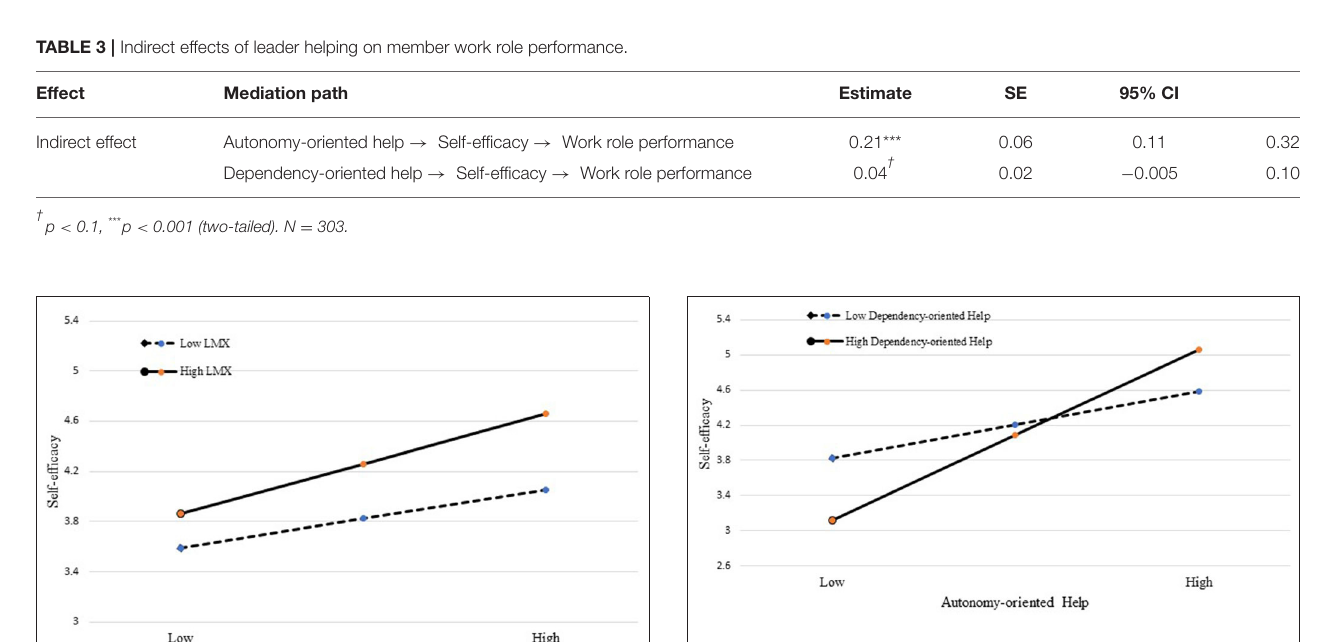
FIGURE 3 | The interactive effect of autonomy-oriented help and dependency-oriented help on